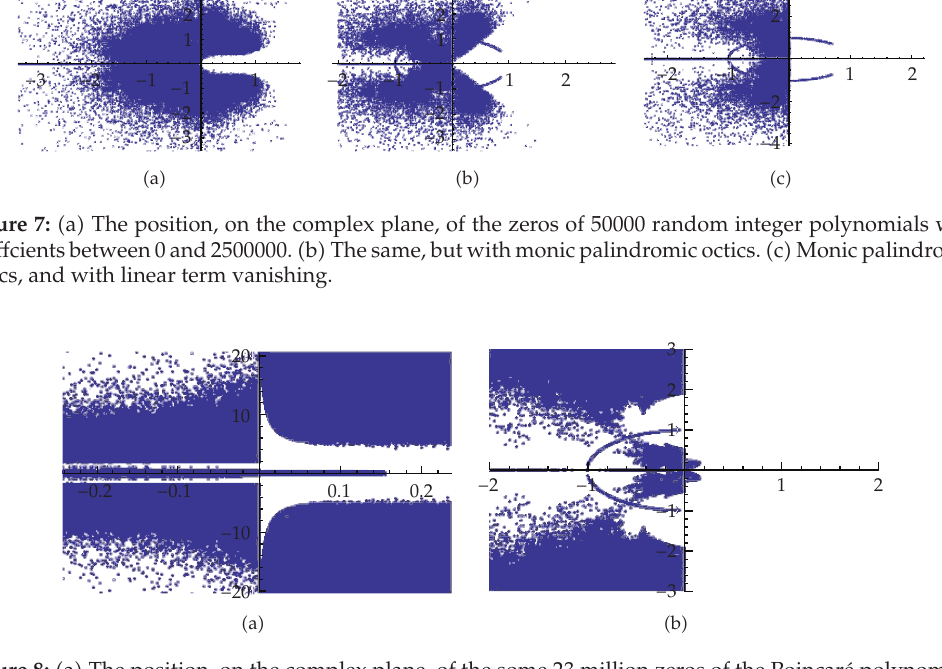
Figure 8: (cid:5) a (cid:6) The position, on the complex plane, of the some 23 million zeros of the Poincar´e polynomials of the approximately 1 million smooth Calabi-Yau fourfolds arising as hypersurfaces in toric fivefolds. (cid:5) b (cid:6) A slightly magnified area emphasizing the ordinate in the range (cid:3) − 1 , 1 (cid:4)